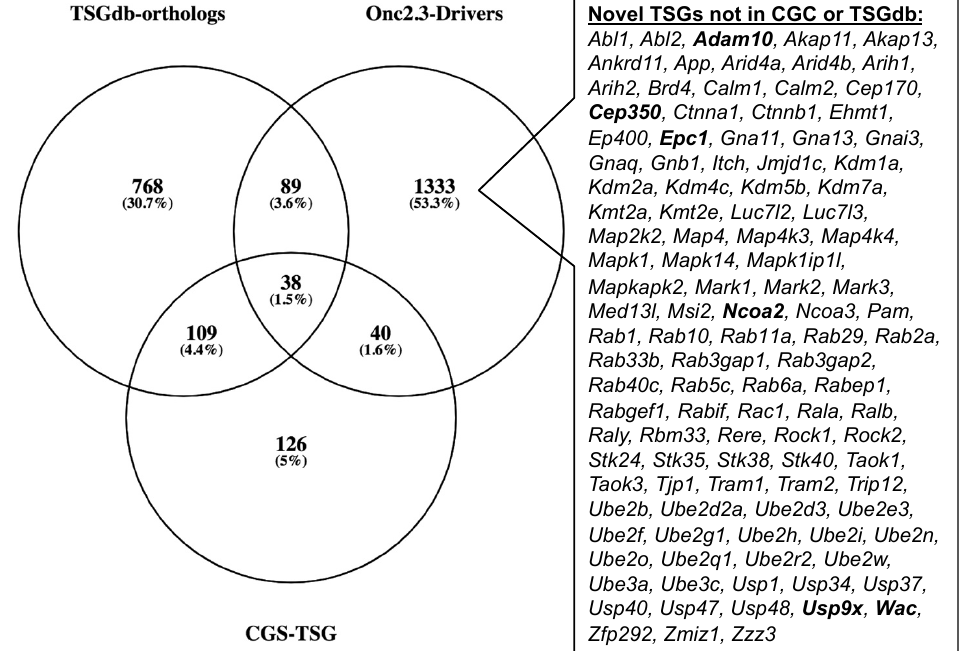
Figure 7. SB-Onc2.3-Pan-TSG driver enrichment with known TSGs datasets. The CGC TSG and TSGdb datasets overlap with 167 of the SB-Onc2.3-Pan-TSG driver genes. There are 111 putative novel TSGs not in the CGC TSG or TSGdb datasets, including validated TSGs (bold) described in the main text.